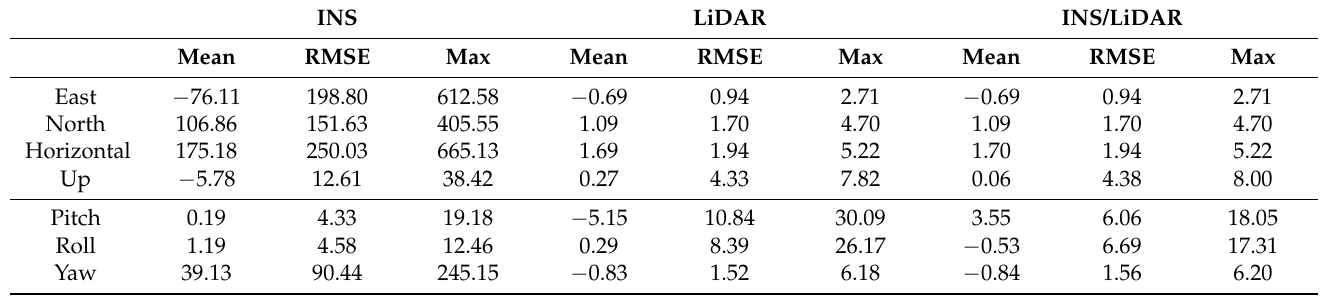
Table 3. GNSS assisted—position (m) and attitude (deg) error statistics.